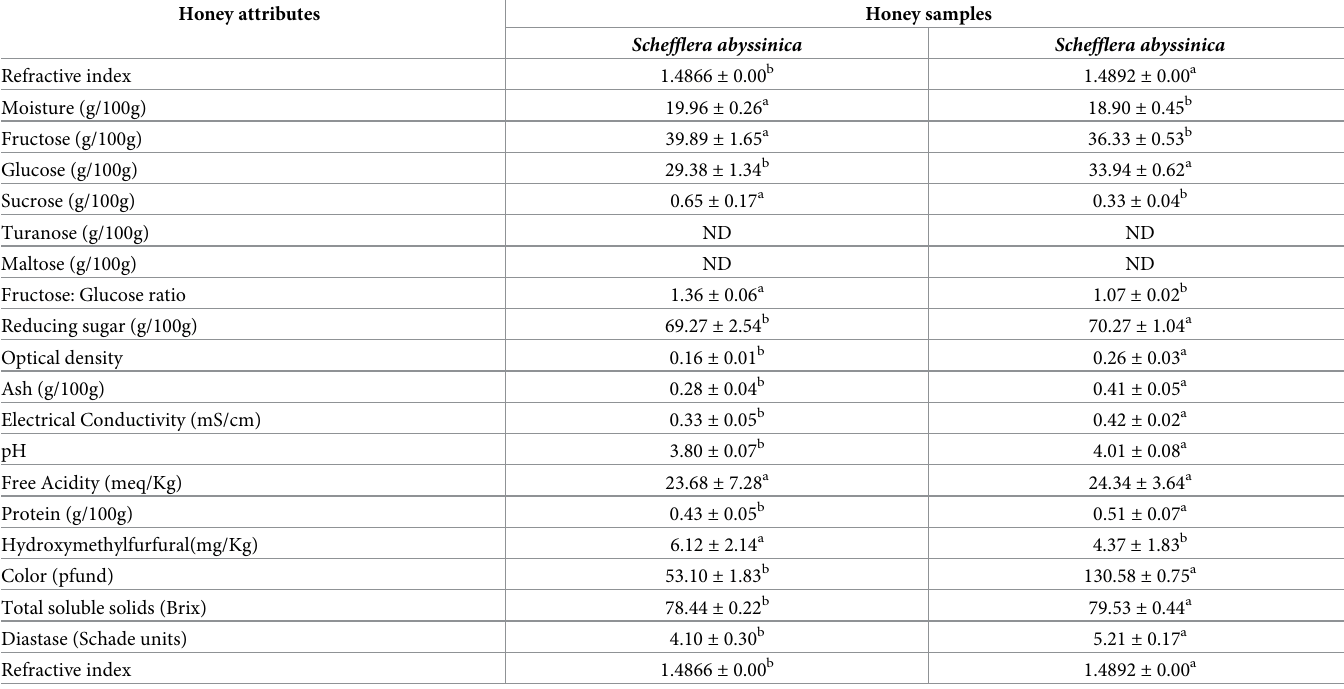
Table 3. Physicochemical properties and sugar profile (mean ± SD) of Schefflera abyssinica and polyfloral honey (n = 20). Honey